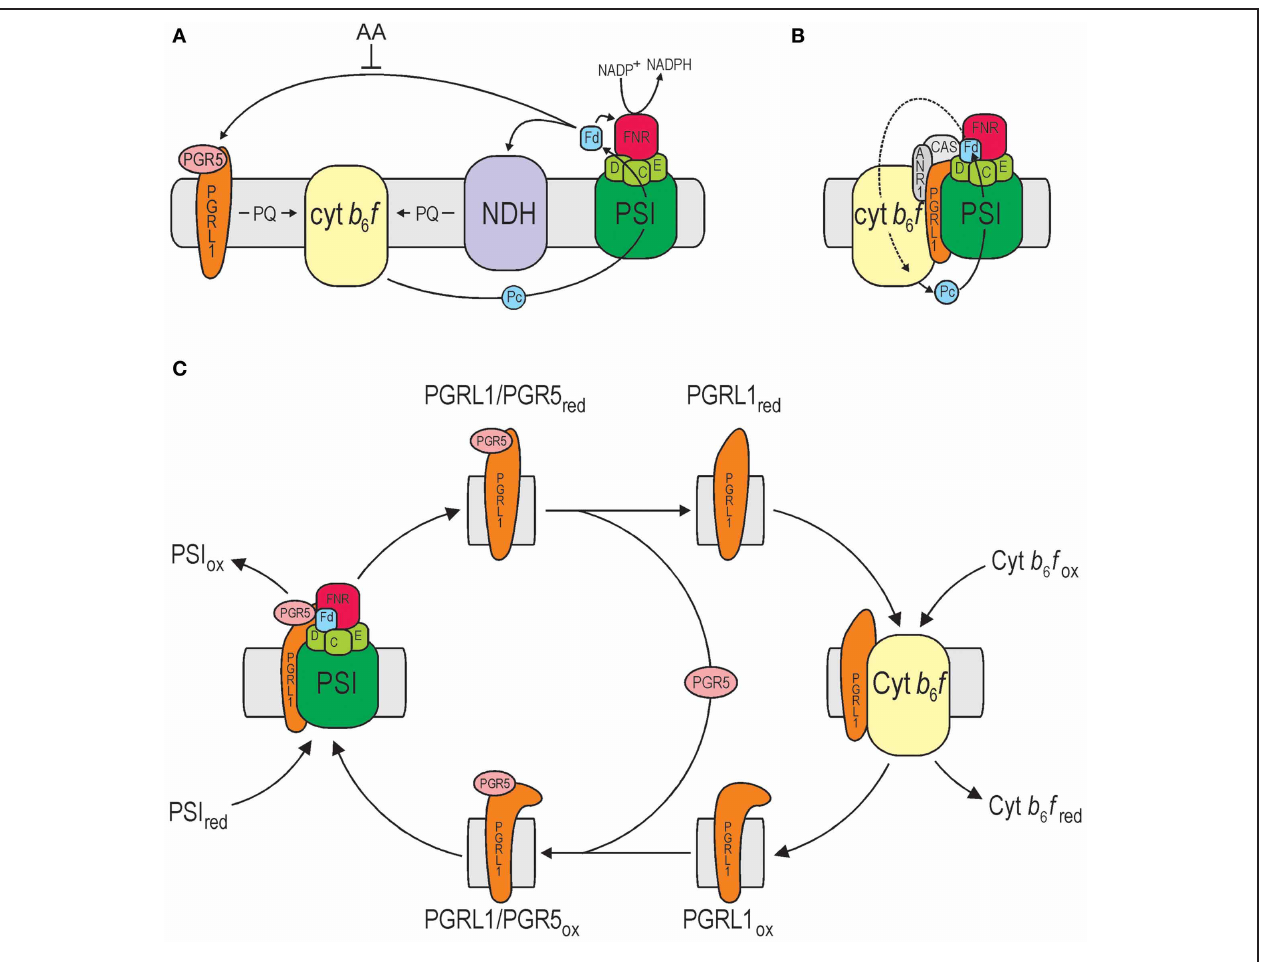
FIGURE 1 | Model of the role of PGRL1/PGR5 in CEF. (A) A schematic representation of CEF around PSI in vascular plants, which operates via two partially redundant pathways (Munekage et al., 2004), an NDH-dependent and the PGRL1/PGR5-dependent pathway. Only the latter is inhibited by AA.